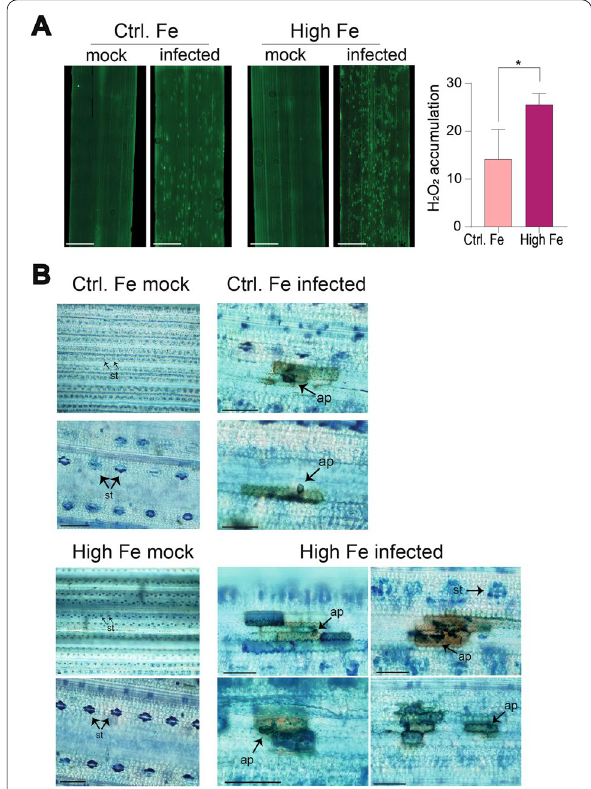
Fig. 8 Accumulation of ROS and Fe in leaves of Control and High‑Fe rice plants. A ROS (H 2 O 2 ) was detected in leaves using the fluorescent probe H 2 DCFDA. Leaves (youngest developed leaves) from mock‑inoculated (mock) and M. oryzae ‑inoculated plants (48 hpi) were examined. Bars correspond to 2 mm. Right panel, quantification of ROS fluorescence using Image J software (three independent experiments, 100 fields, each). Asterisks indicate statistically significant differences calculated by two‑way ANOVA (* P 0.05). B Fe detection ≤ in leaves of Control‑Fe (upper panels) and High‑Fe (lower panels) plants that have been mock‑inoculated or infected with M. oryzae (48 hpi). The youngest developed leaf (third leaf) was subjected to DAB staining (brown) followed by Perls staining (blue). Bars correspond to 50 μm. St, stomata, Ap: